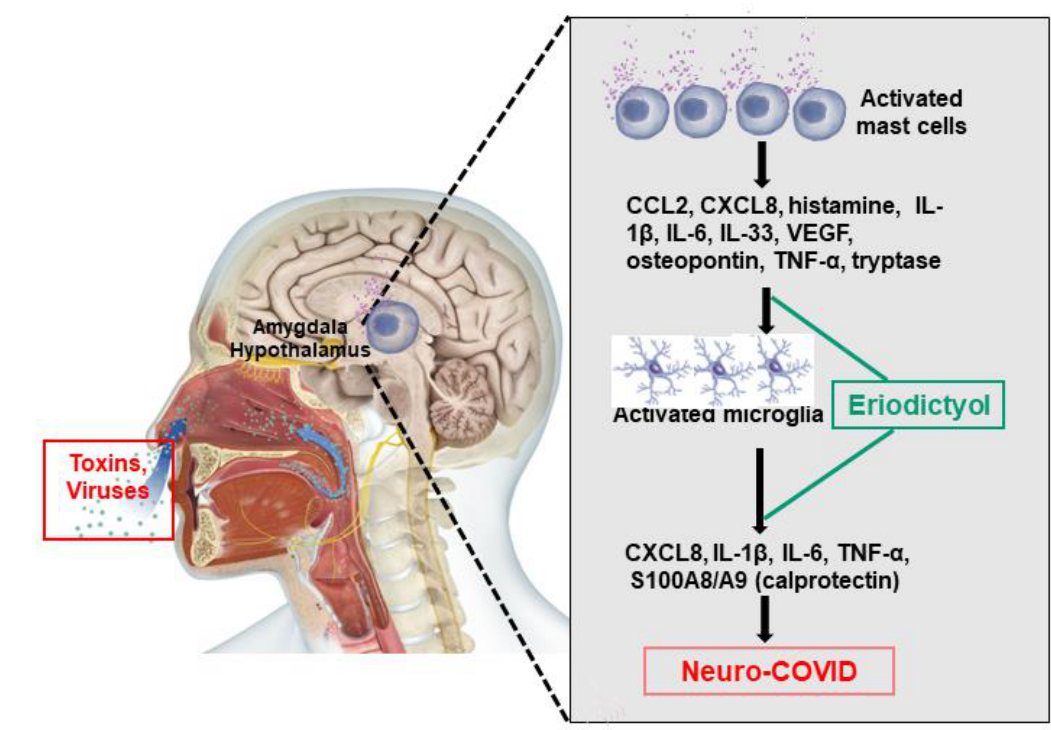
Figure 2. Schematic diagram showing the proposed beneficial effects of eriodictyol. Neuro-COVID can activate mast cells, and several inflammatory mediators released from activated mast cells can activate microglia and other brain cells to release inflammatory and neurotoxic mediators that can cause neuroinflammation and neurodegeneration and exacerbate neuro-COVID disease severity. Eri- odictyol could inhibit neuro-COVID-associated mast cell activation-mediated inflammatory mediator release as well as inflammatory mediators released from activated microglia. These inhibitions could reduce the disease severity or treat neuro-COVID.